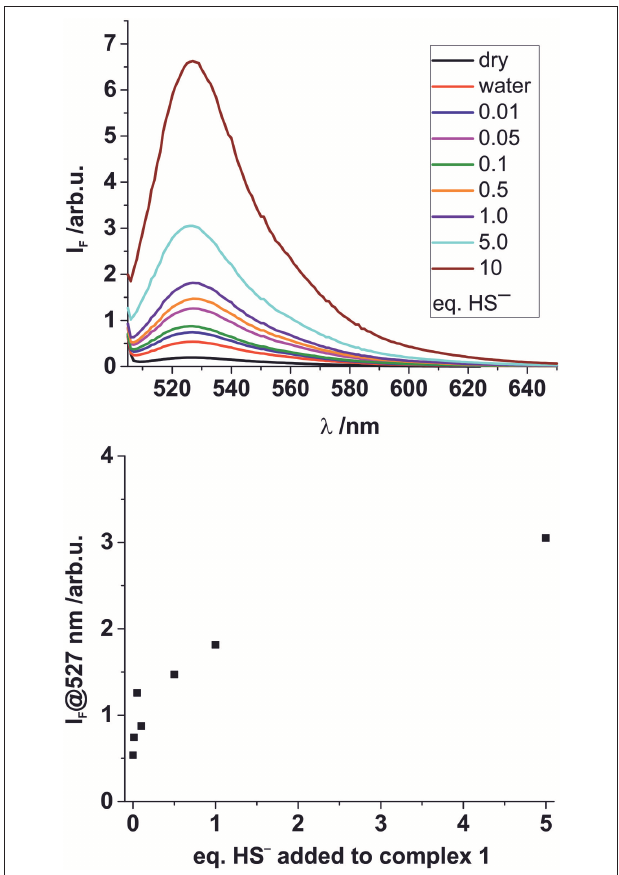
FIGURE 5 | Top: Fluorescence response of solid complex 1 (5 × 10 − 8 mmol per well) deposited on hydrogel D4 in a 96 well-microplate upon addition of 50 µ L of aqueous Na 2 S solutions of different concentrations. Eq., of Na 2 S added as indicated. Bottom: Concentration dependency of the fluorescence response at the emission maximum.